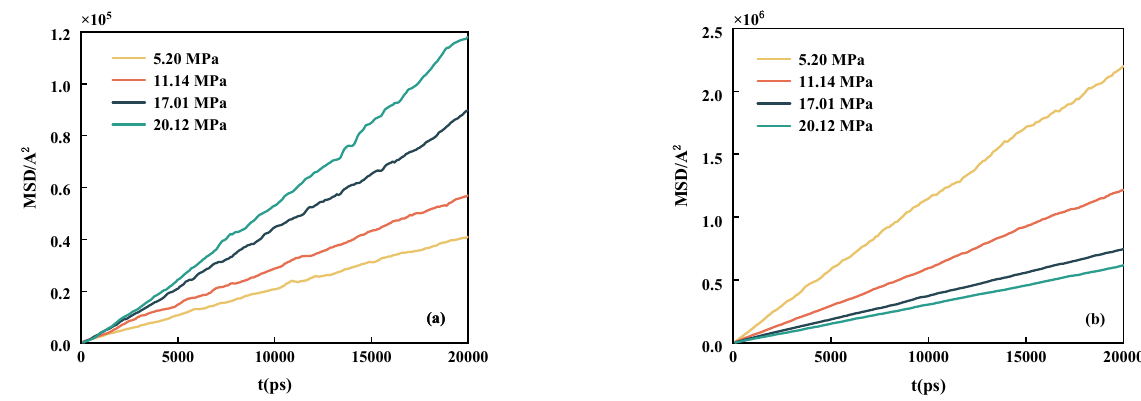
Figure 9. IFT of different component systems at 313.3 K.